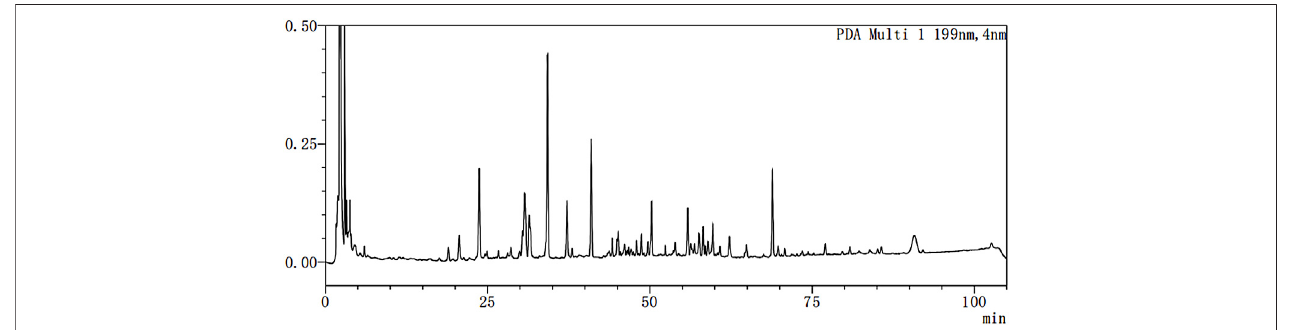
FIGURE 1 | Fingerprint chromatogram of Yishen Huashi